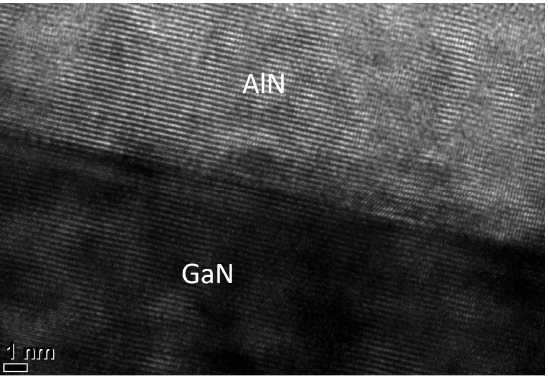
Figure 8. Cross-sectional STEM image of the AlN/n-GaN interface (NH 3 plasma power: 30 W).